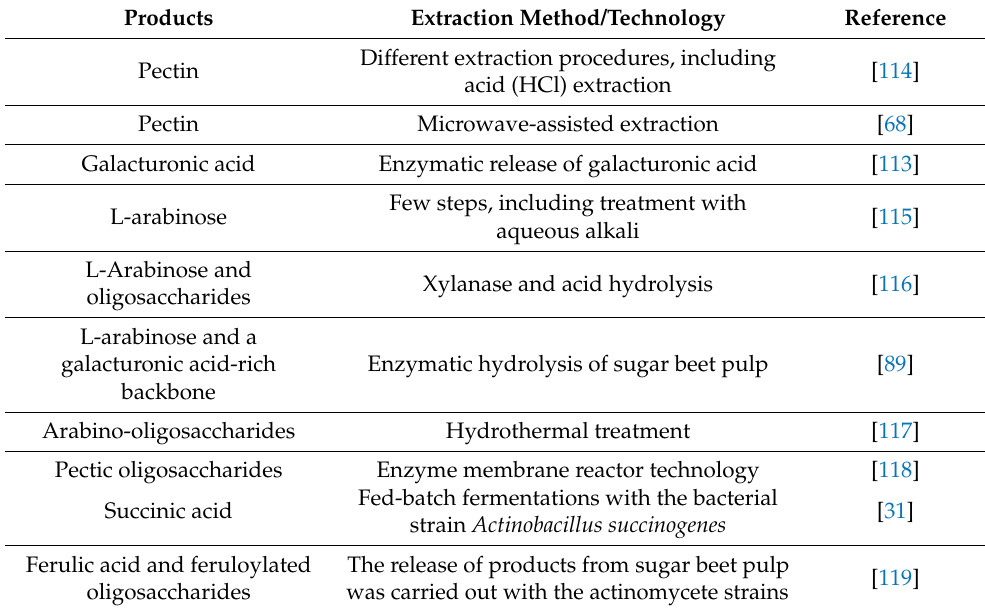
Table 4. Processes used for obtaining valuable intermediates and bioproducts from sugar beet pulp.